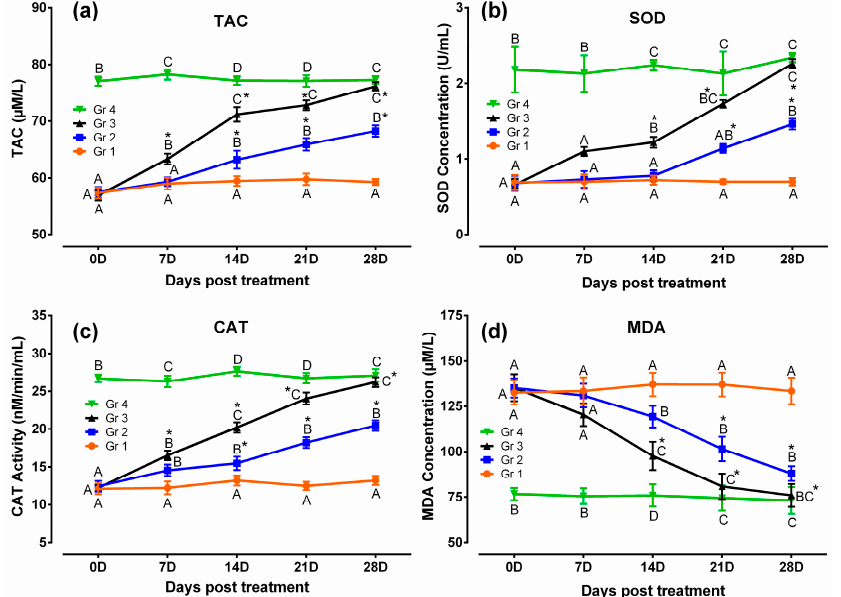
Figure 4. Antioxidant and oxidative stress profiles in humpsore-treated cattle: ( a ) Total antioxidant capacity, ( b ) superoxide dismutase, ( c ) catalase, and ( d ) malondialdehyde. Data are shown as mean ± SEM. Two-way analysis of variance (ANOVA) followed by Tukey post-test was performed to find out significant difference among different groups at a time and among different time points in a group. A,B,C,D Value with different superscript in a particular time point indicate significant difference among groups. Value with star (*) in a group indicates significant difference as compared to its respective 0 day value. Gr 1: infected animals without treatment, Gr 2: treatment group with ivermectin alone, Gr 3: treatment group with tri-model therapy, and Gr 4: negative control.